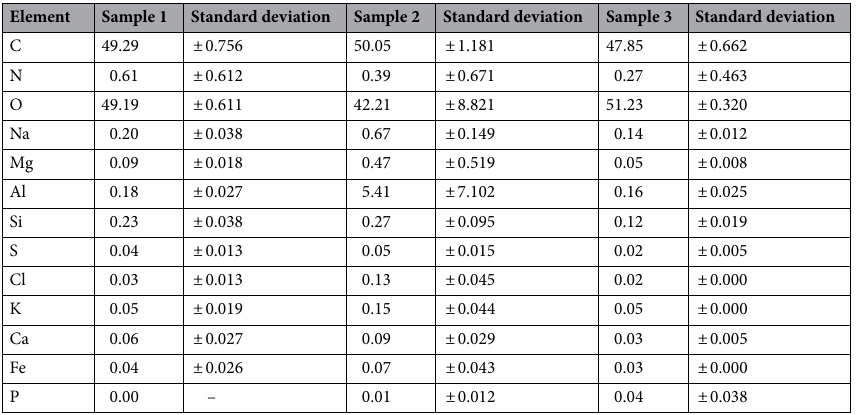
Table 2. Elemental composition of the supernatant fraction after separation from algal samples collected in different sites in Svalbard: 1—sample from Longyearbreen Glacier, elevation 417 m, 2—from Upper Foxfonna Glacier, elevation 789 m, 3—from Lower Foxfonna Glacier, elevation 609 m.